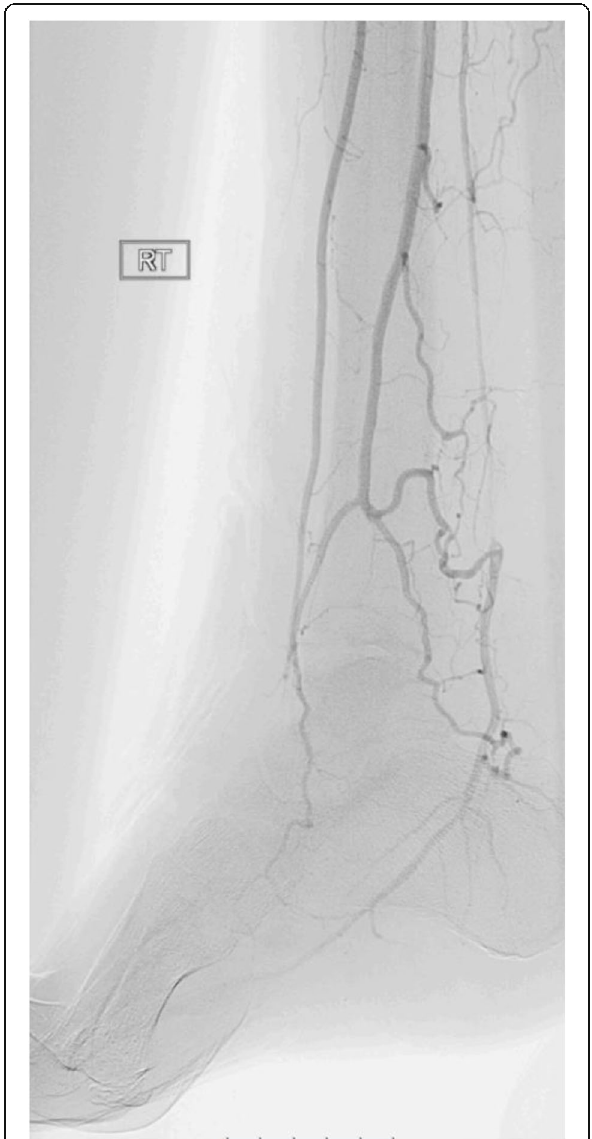
Fig. 8 Runoff to the foot after the